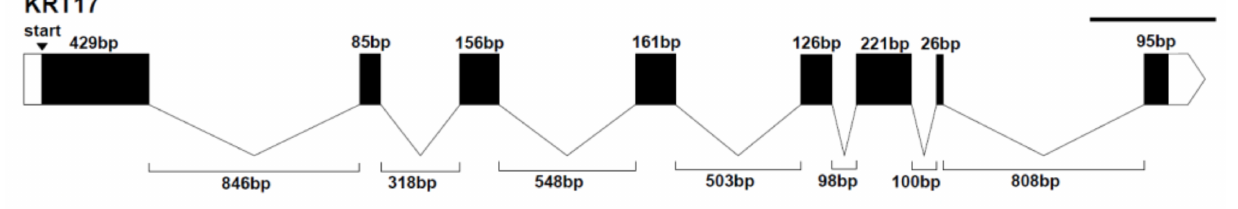
Figure 3. Structure of KRT17. White boxes represent the non-coding regions, black boxes represent the exons, and the broken lines represent the intron